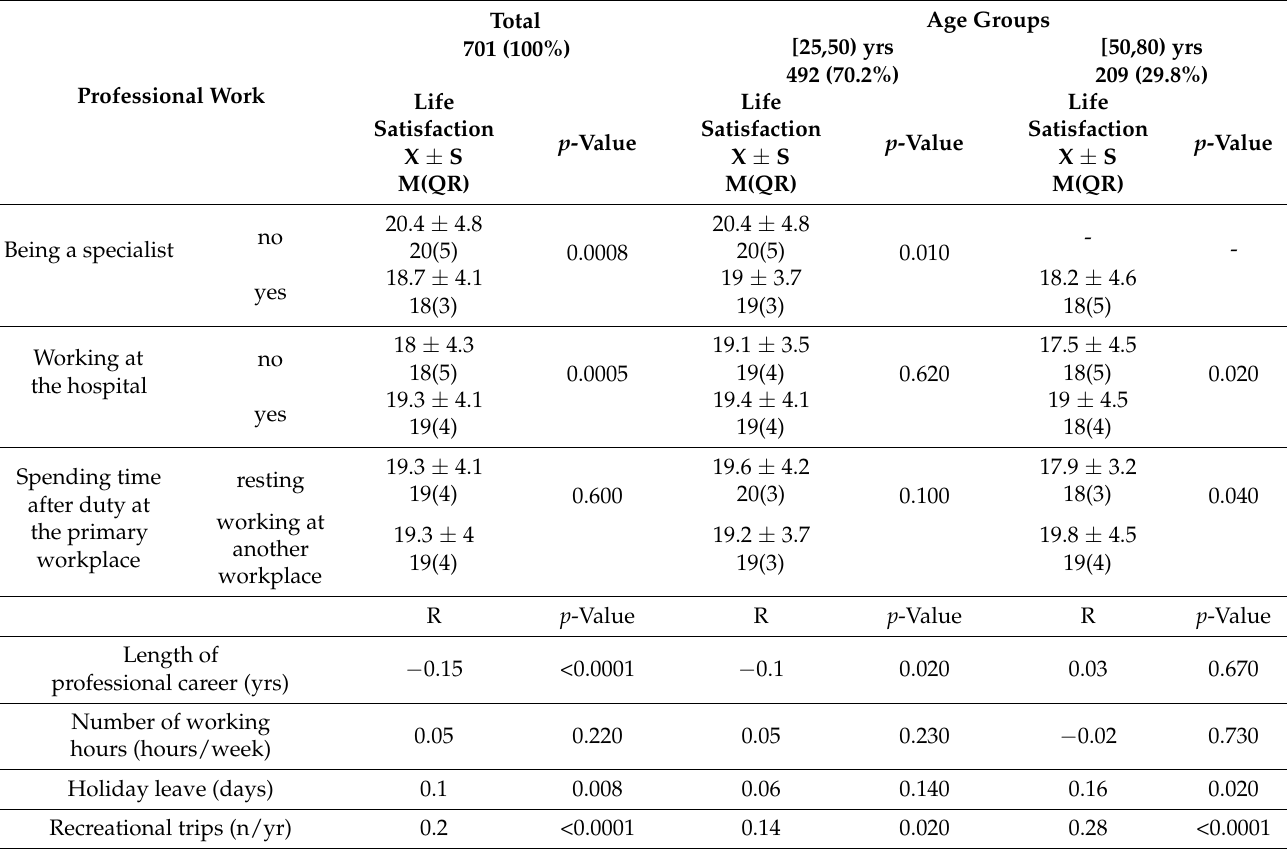
Table 2. Influenceofdatarelatedtoprofessionalworkenvironmentonthelifesatisfactionofthephysicians.